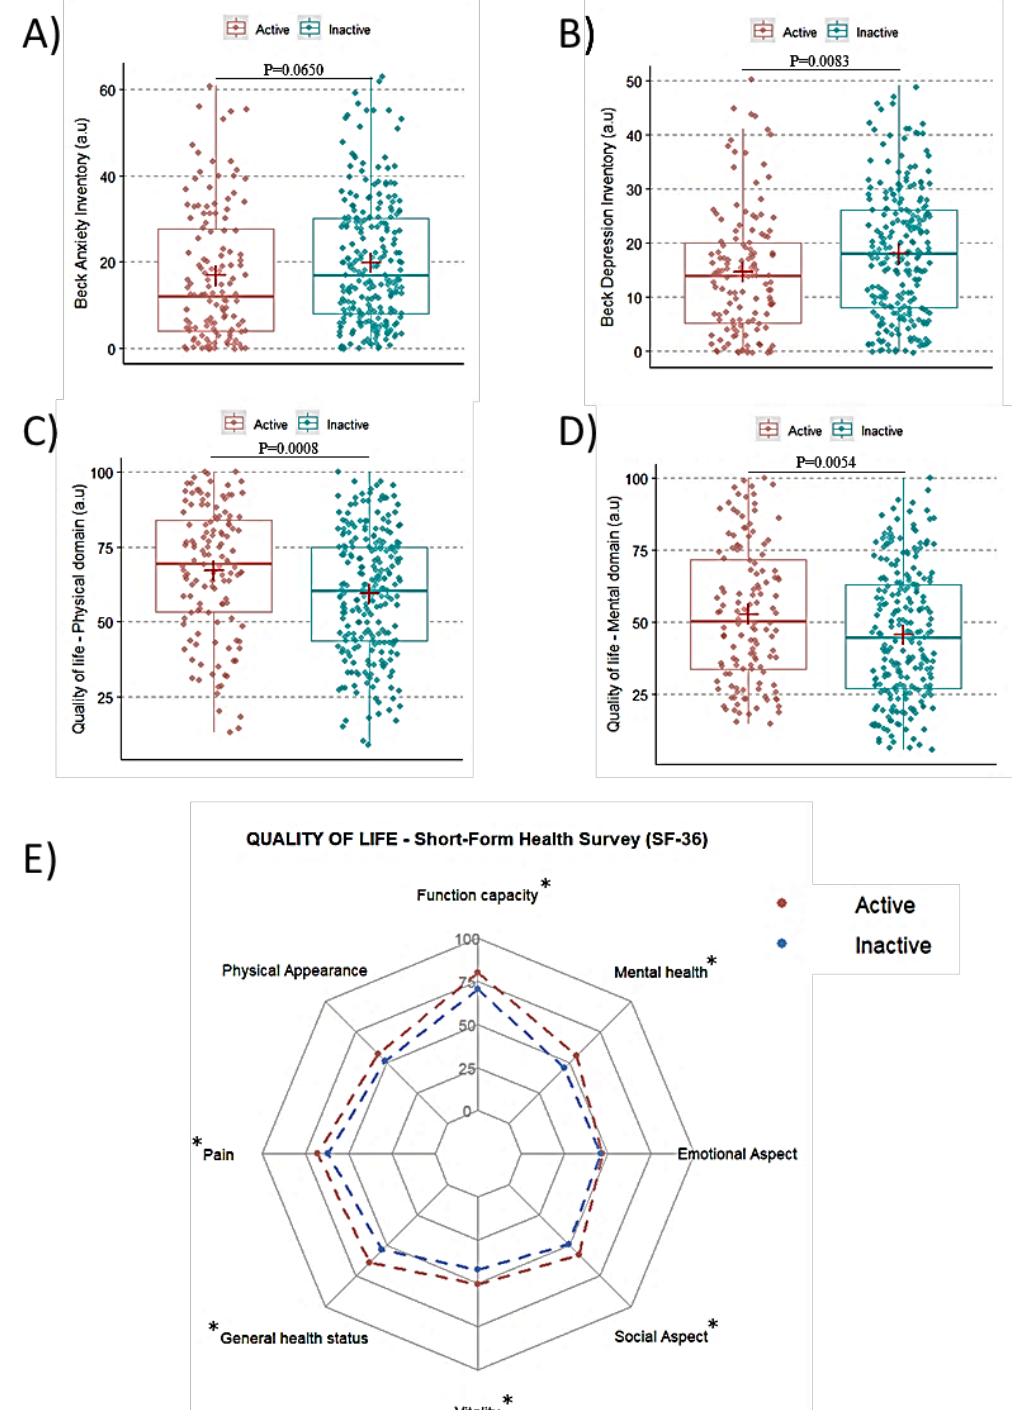
Figure 2. Scores of anxiety, depression, and quality of life in physically active and inactive students. Panel ( A ): Scores obtained in Beck anxiety inventory; Panel ( B ): Scores obtained in Beck depression inventory; Panel ( C ): Scores of quality of life in the physical domain; Panel ( D ): Scores of quality of life in mental domain; Panel ( E ): Radar plot of quality of life in each domain; * Indicates p < 0.05.